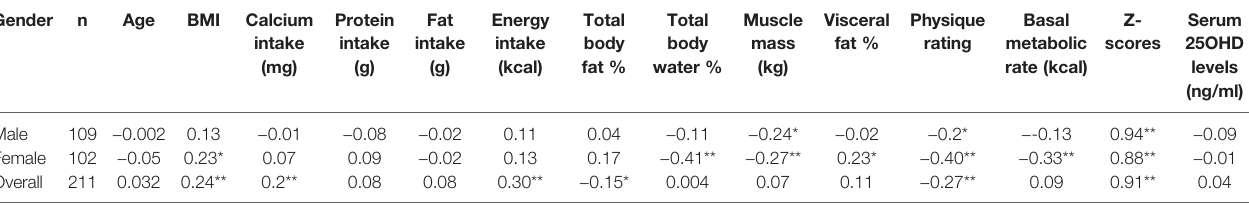
TABLE 3 | Correlation of lifestyle factors, biochemical parameters, anthropometric and BIA measurements with BQI according to gender